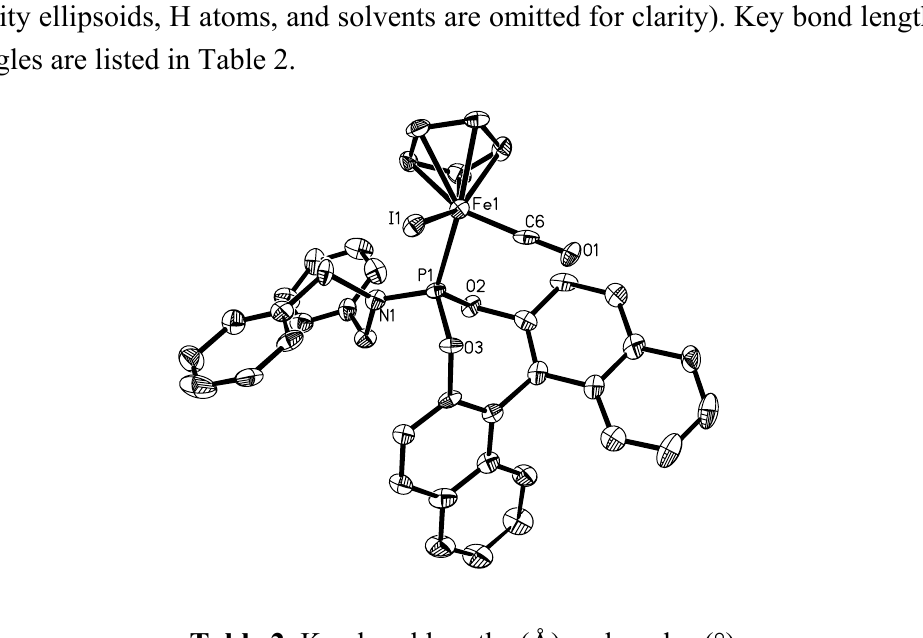
Table 2. Key bond lengths (Å) and angles